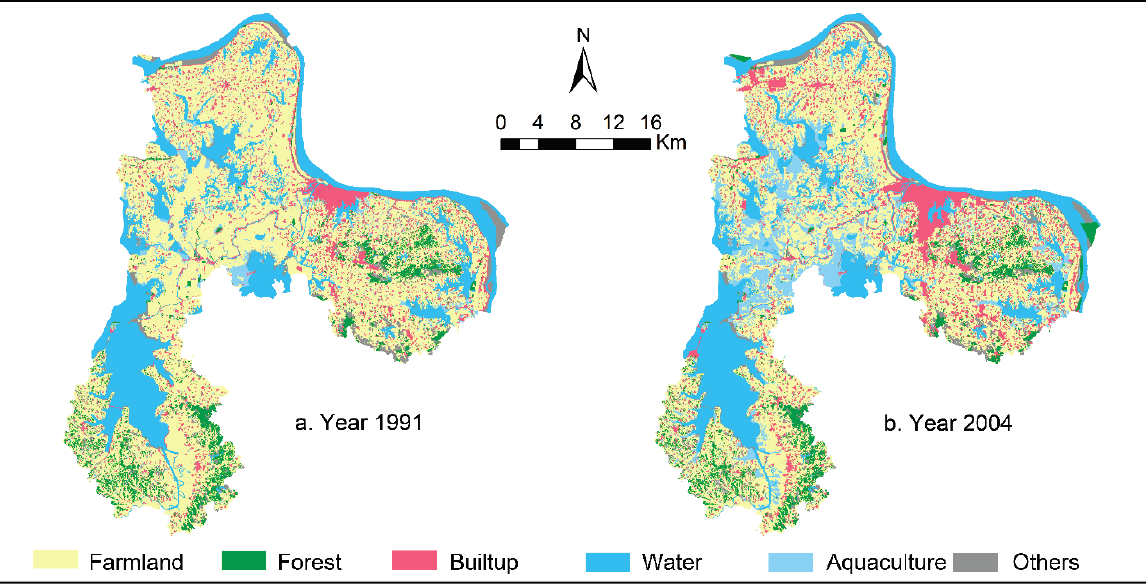
Figure 2. Maps of land cover patterns of Ezhou City in 1991 and